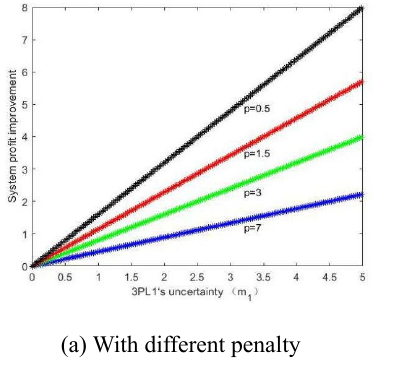
Fig. 8. Profit improvement in 3PL1’s uncertainty